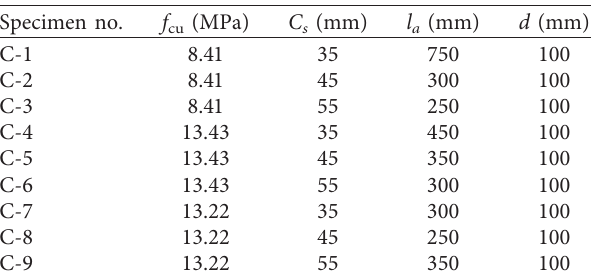
Figure 4: HSG push-out specimens and dial gauge distribution. l a is the steel-gypsum connected length, C s is the gypsum cover thickness, and d is the H-shaped steel section height. Sf-1, Sf-2, Sf-3, Sf-4 are, respectively, the four vertical surfaces of the gypsum cover. Table 1: Characteristics of HSG